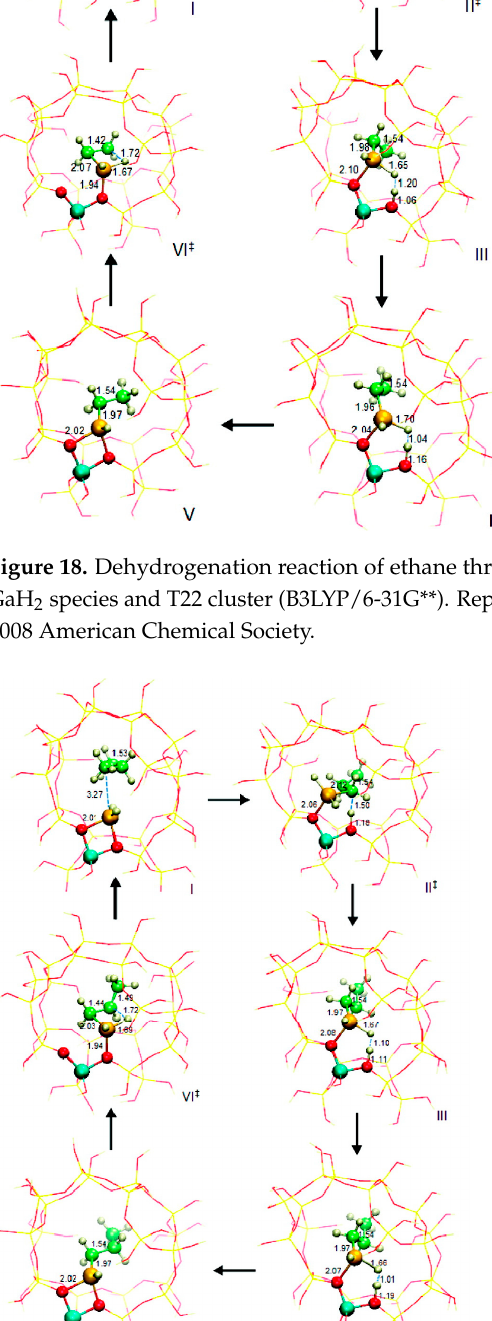
Figure 19. Dehydrogenation reaction of propane through the three-step mechanism (channel 1) computed with GaH 2 species and T22 cluster (B3LYP/6-31G**). Reprinted with permission from ref [133]. Copyright 2006 American Chemical Society.